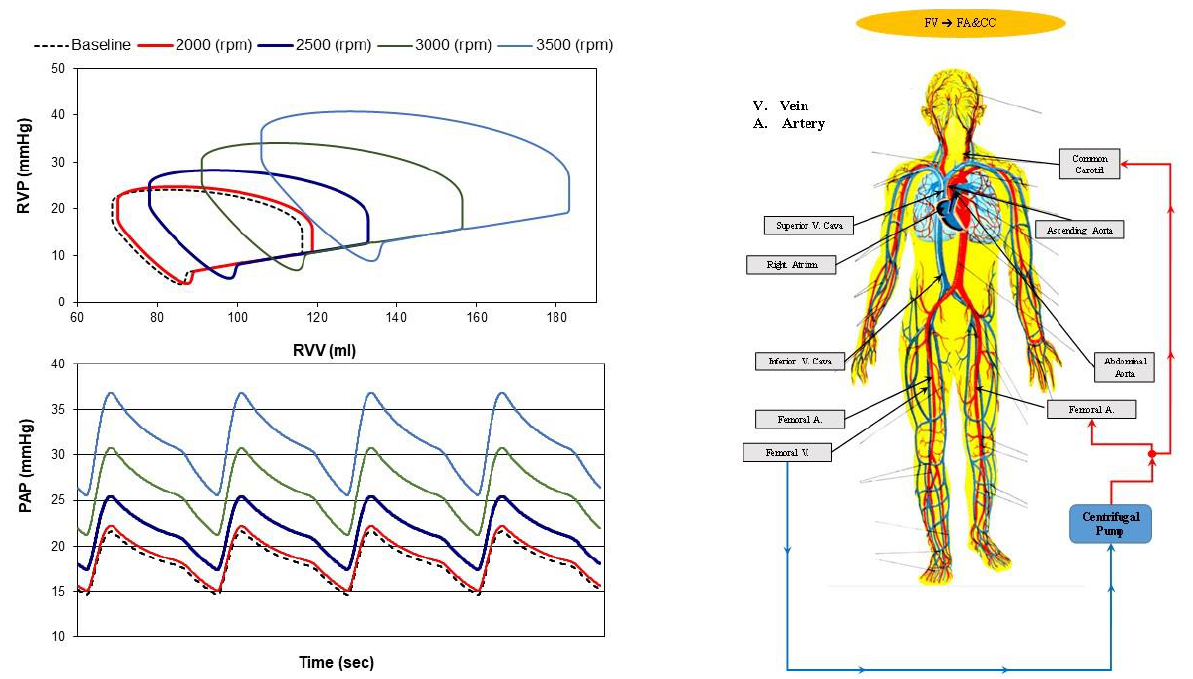
Figure 6. Right ventricular pressure–volume loops ( top left panel ) and instantaneous PAP wave- forms ( bottom left panel ) obtained in baseline conditions (black dashed line) and with FV → FA&CC cannulation when the pump rotational speed was set to 2000 (red line), 2500 (blue line), 3000 (green line) and 3500 (light blue line) rpm. The ventricular loops and the instantaneous waveforms obtained using CARDIOSIM© were stored in excel files and subsequently plotted. In FV → FA&CC cannulation ( right panel ), the centrifugal pump draws blood from the femoral vein and ejects it into the femoral artery and common carotid artery bilaterally.